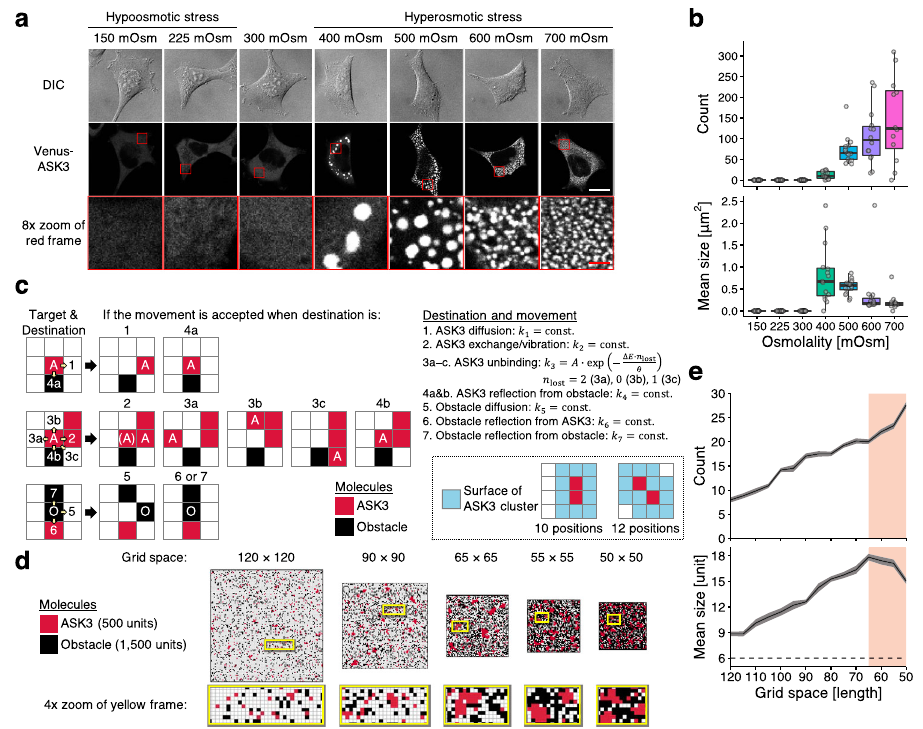
Fig. 1 ASK3 forms macromolecular crowding-driven condensates under hyperosmotic stress. a , b Subcellular localization of ASK3 5 min after osmotic stress in Venus-ASK3-stably expressing HEK293A (Venus-ASK3-HEK293A) cells. Hypoosmotic stress: ultrapure water-diluted medium, hyperosmotic stress: mannitol-supplemented medium, DIC: differential interference contrast, white bar: 20 μ m, red bar: 2.5 μ m. Data: center line = median; box limits = [ Q 1 , Q 3 ]; whiskers = [max(minimum value, Q 1 − 1.5 × IQR), min(maximum value, Q 3 + 1.5 × IQR)], where Q 1 , Q 3 and IQR are the fi rst quartile, the third quartile and the interquartile range, respectively; n = 12 (700 mOsm), 14 (600 mOsm), 15 (400 mOsm), 16 (150 mOsm, 225 mOsm, 300 mOsm and 500 mOsm) cells pooled from four independent experiments. Note that the signal intensity of DIC cannot be compared among the images. c Schematic diagram of a computational model for protein diffusion and clustering in a two-dimensional grid space. Red squares: ASK3 units, black squares: obstacles, pale yellow arrows: potential movements, blue squares: surface positions of the clusters. See Supplementary Note for the full description of the model. d , e A computational simulation for the relationship between the grid space and the number/size of ASK3 clusters. Results after 5 × 10 6 steps in the rejection kinetic Monte Carlo (rKMC) method at each grid space are presented. Red shading: the assumed range corresponding to hyperosmotic stress (details in Supplementary Discussion), dashed line: the minimum of ASK3 clusters de fi nition. Data: mean ± SEM, n = 18